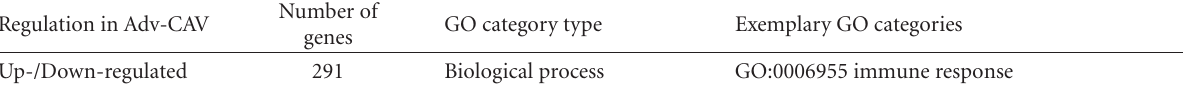
Table 3: Gene ontology categories enriched by genes expressed di ff erentially between patients with and without advanced CAV. Regulation in